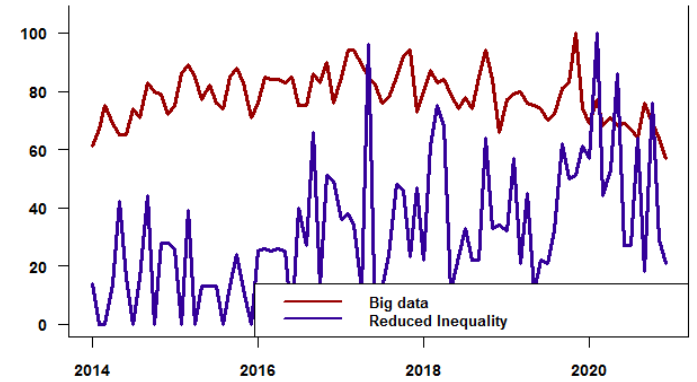
Figure 11. Big Data and SDG 10 global Google trends since 2014. Inequality not only exists in terms of gender and race but exists across all